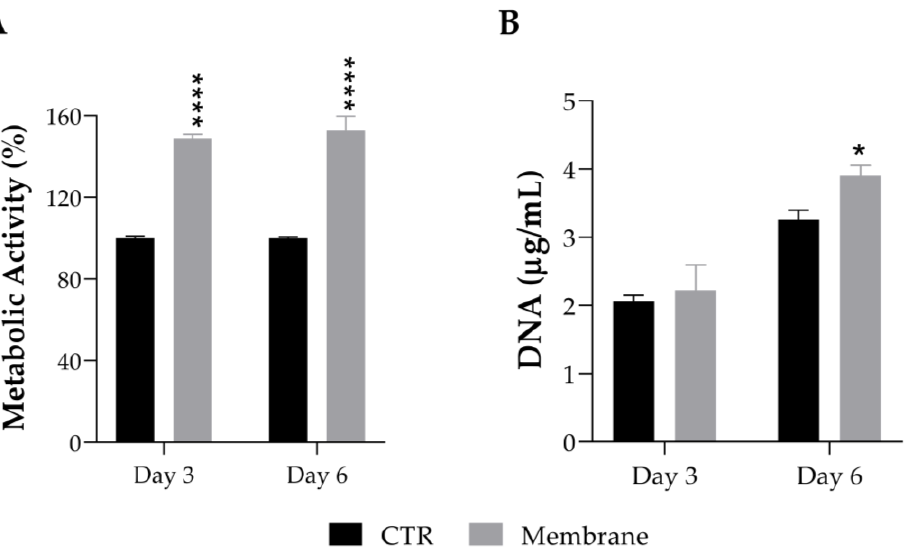
Figure 8. Cell viability and proliferation of HaCaT keratinocytes after being cultured with an ASColl membrane during up to 6 days. ( A )—Metabolic activity, as measured by MTS assay. ( B )—DNA quantification, as measured by PicoGreen assay. The presented values are mean ± SD of at least three independent experiments and the data were considered statistically different if p < 0.05, when compared with non-treated cells (CTR) by two-way ANOVA, followed by Tukey’s test. * p < 0.05; **** p < 0.0001.